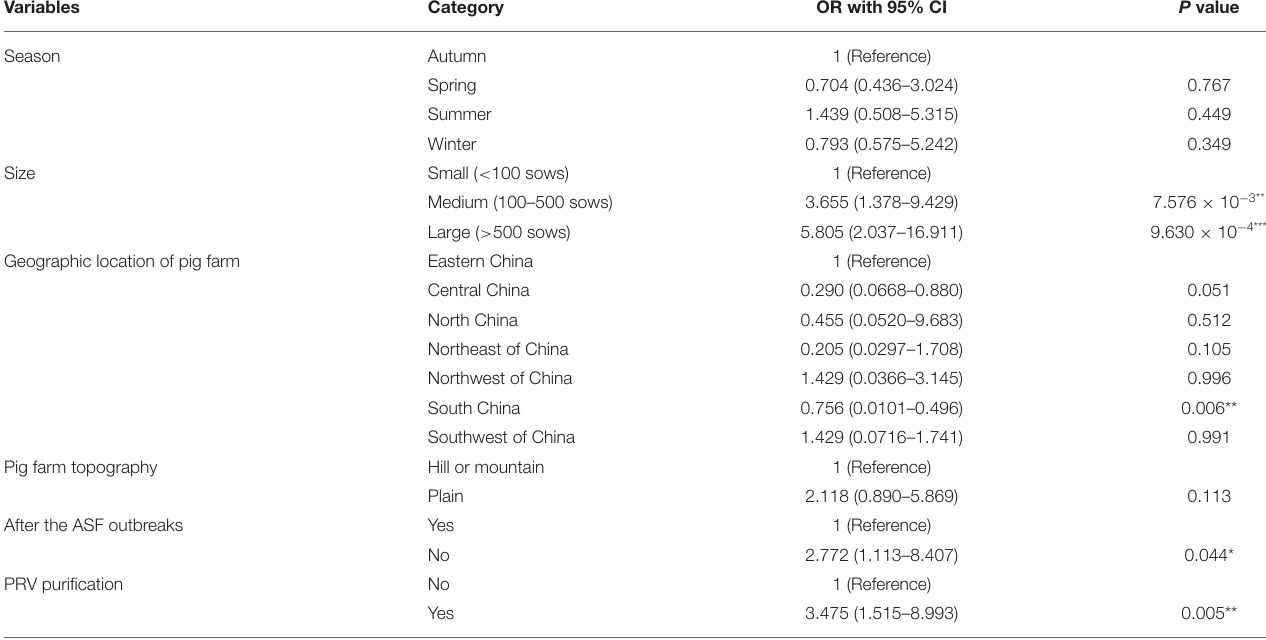
TABLE 3 | Univariate logistic analysis of risk factors associated with PRRSV serological status of pig farm levels.